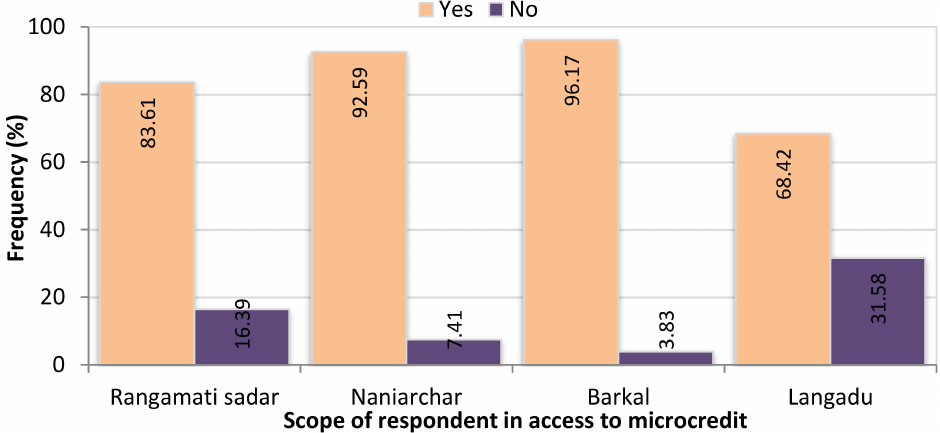
Figure 4. Status of access to microcredit in the studied areas of Kaptai lake.